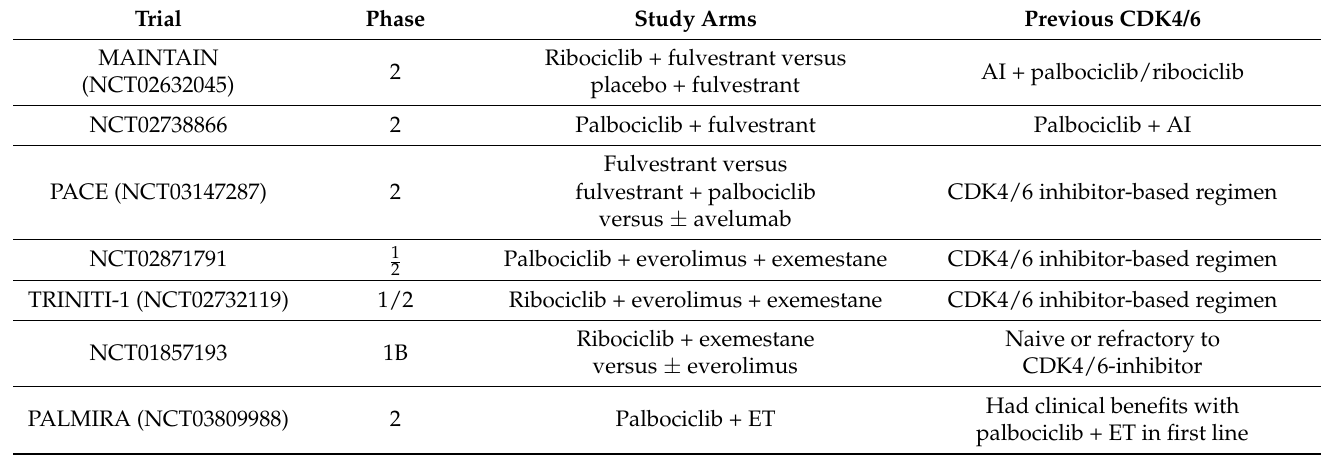
Table 3. Ongoing studies based on CDK4/6 inhibitors beyond